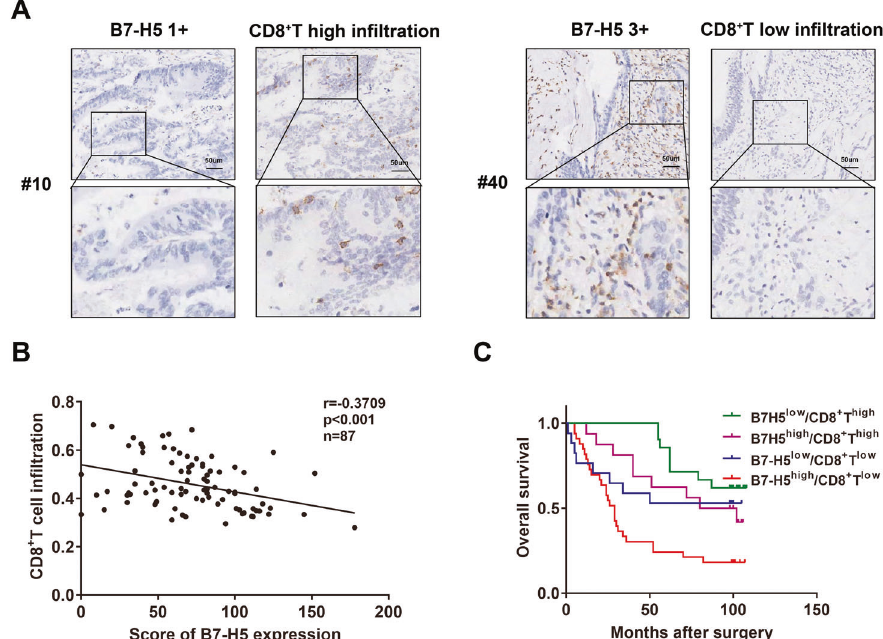
Fig. 2 Relationship between B7-H5 and CD8 + T-cell in fi ltration in CRC. A Representative B7-H5 and CD8 + T IHC staining images from patients #10 and #40 were shown. B The correlation between B7-H5 expression and CD8 + T-cell in fi ltration was analyzed. r = − 0.3709, P < 0.001. C Kaplan − Meier curves of overall survival of CRC patients according to four subtypes based on B7-H5 and CD8 expression.